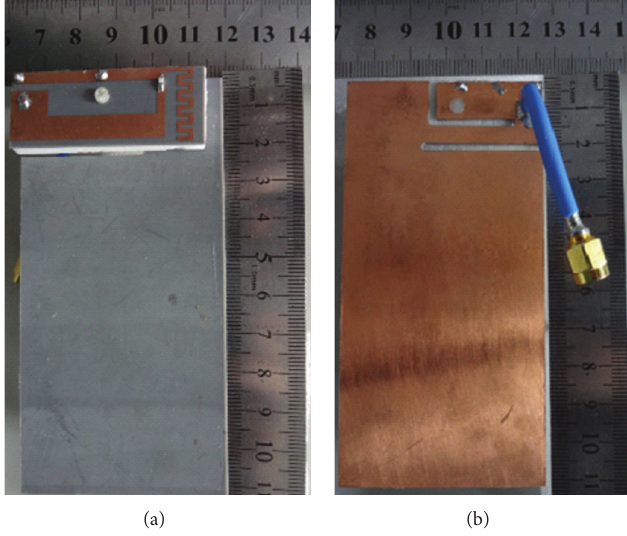
Figure 5: Photos of the manufactured antenna: (a) top side and (b) back